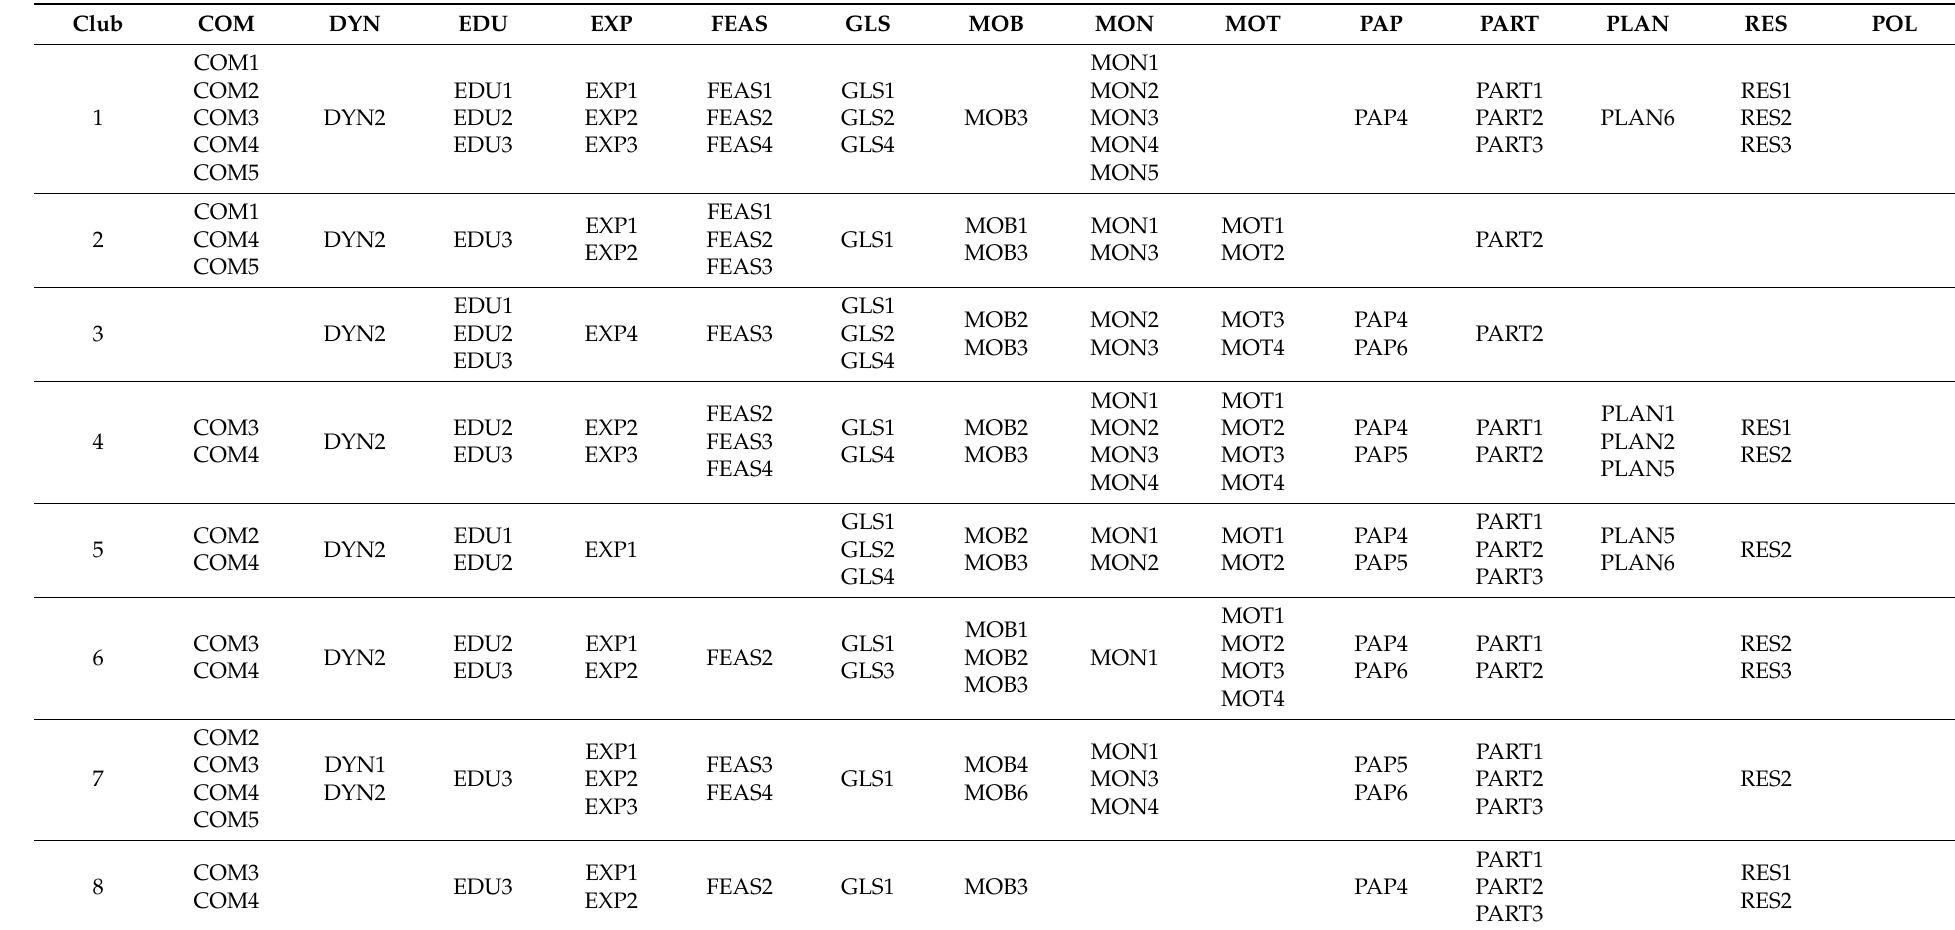
Table 2. Summary of implemented strategies and intervention components among sports